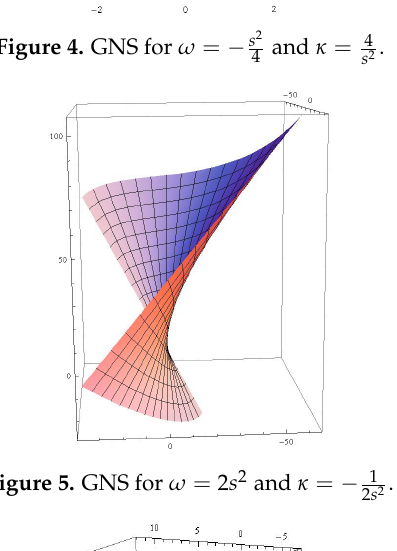
Figure 4. GNS for ω = − s 2